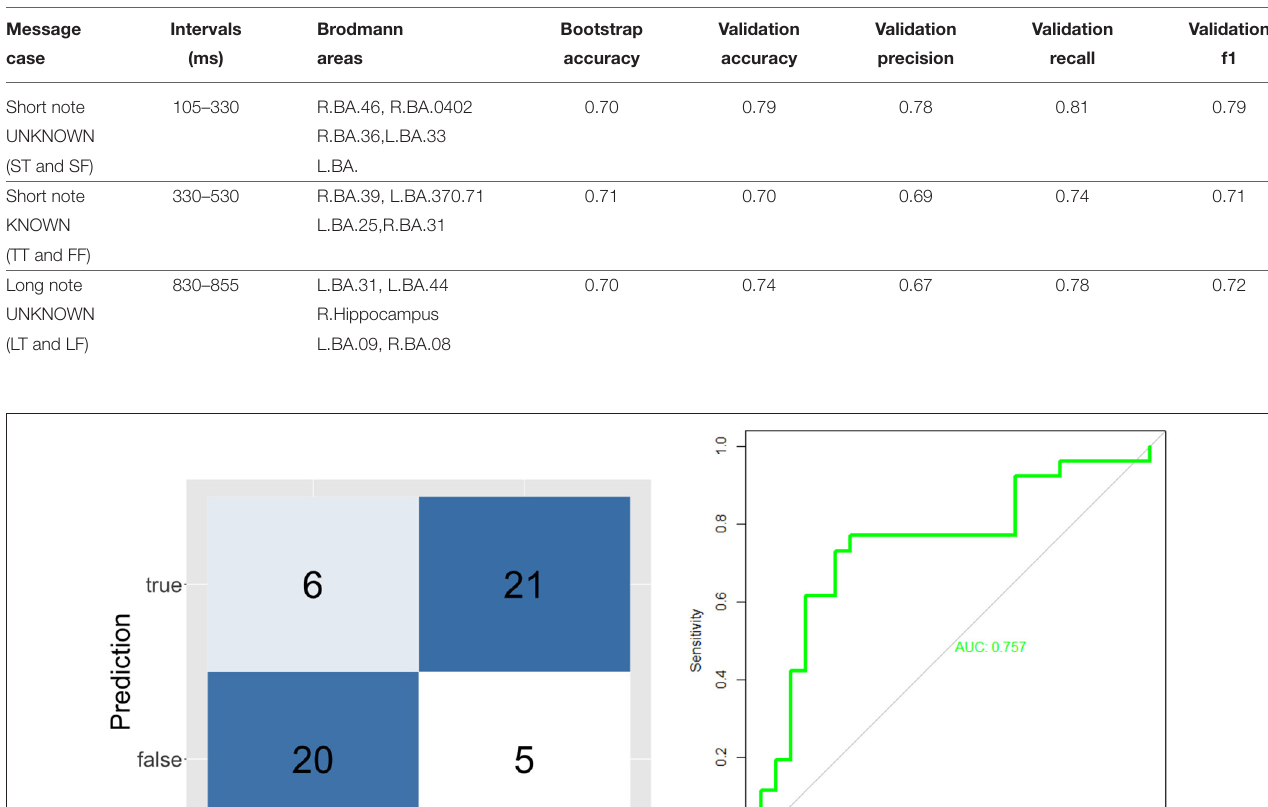
TABLE 1 | Best models’ scores for each case used for verification of hypothesis 2.